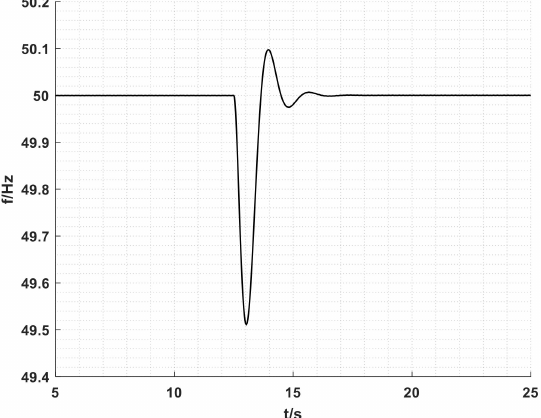
Figure 12. The effect of the total wind and photovoltaic generator set resection on the